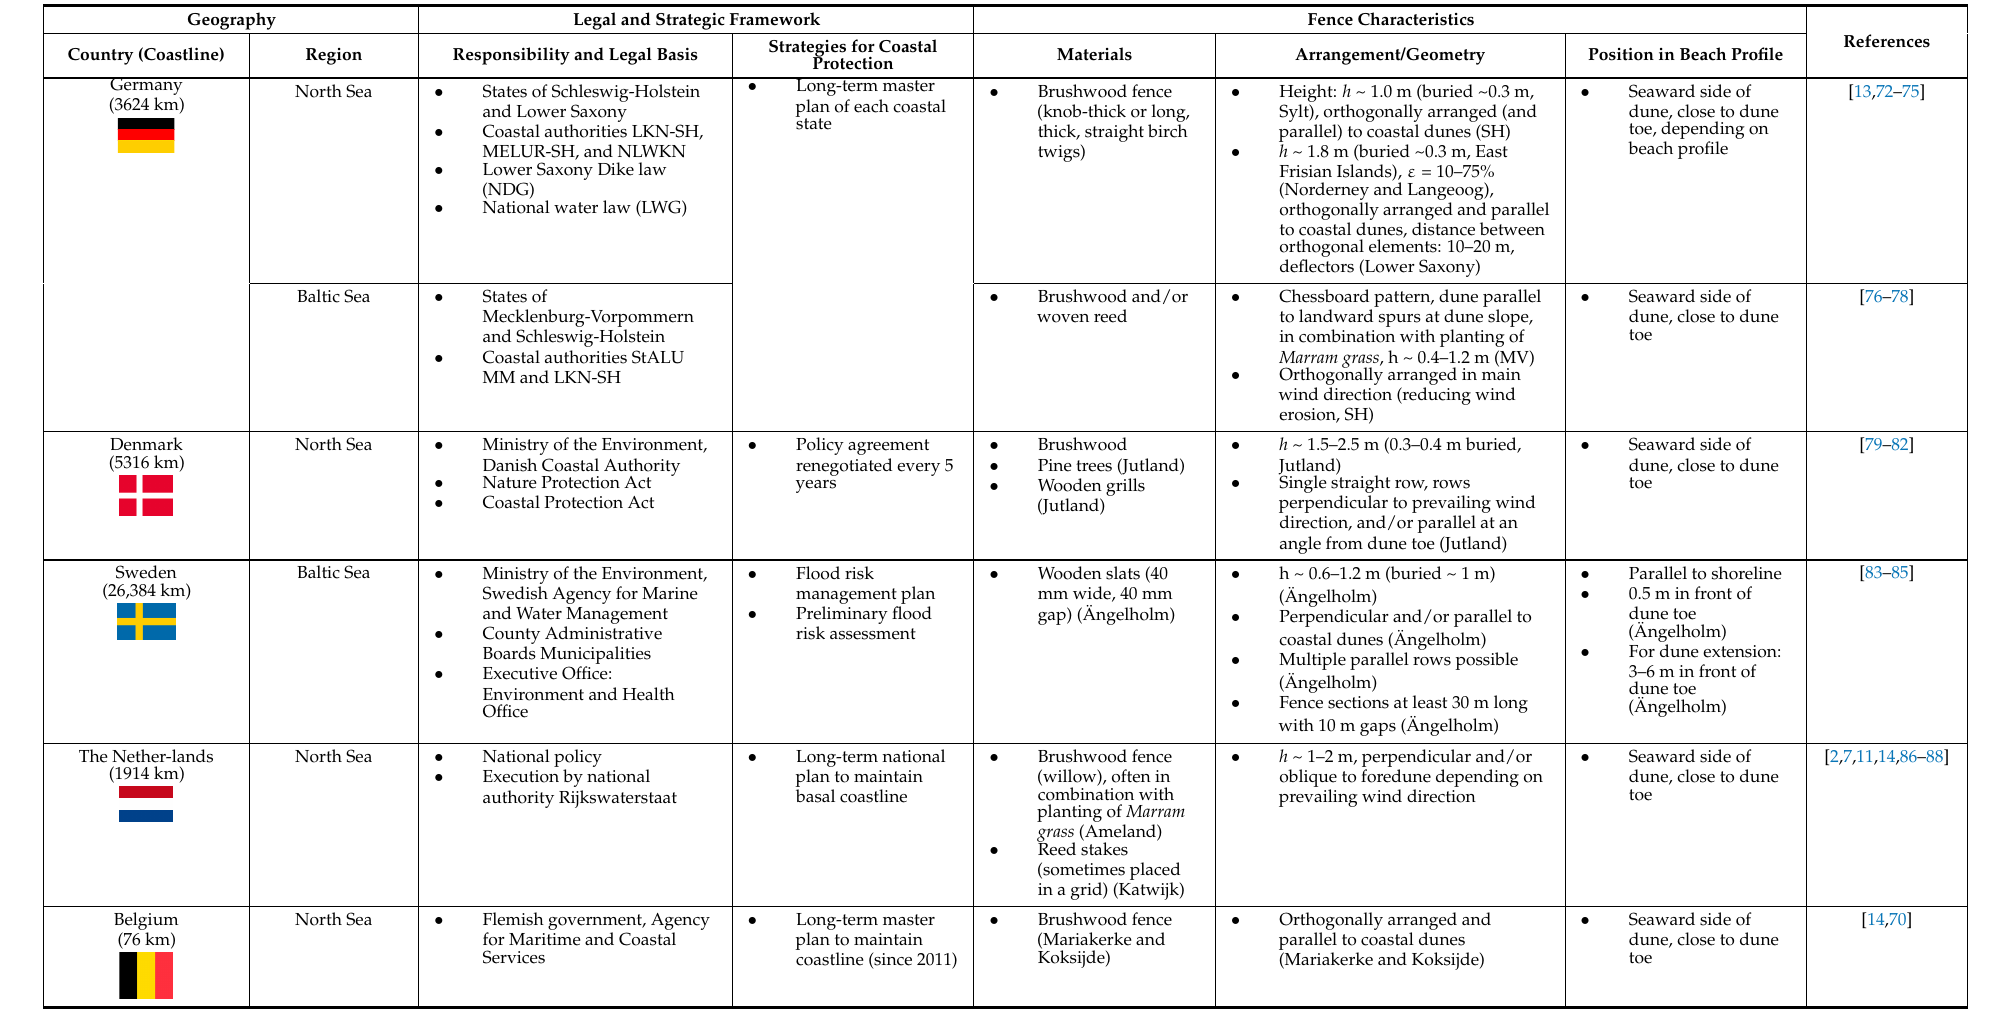
Table 1. International overview showing examples of installed sand trapping fences.